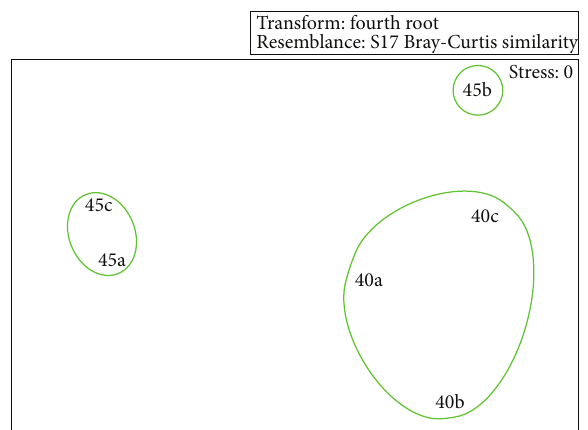
Figure 3: nMDS plot of surface sediment samples collected at stations 40 and 45 in Bay of Vlor¨e. Hierarchical clustering super- imposed with cutoff at 60%